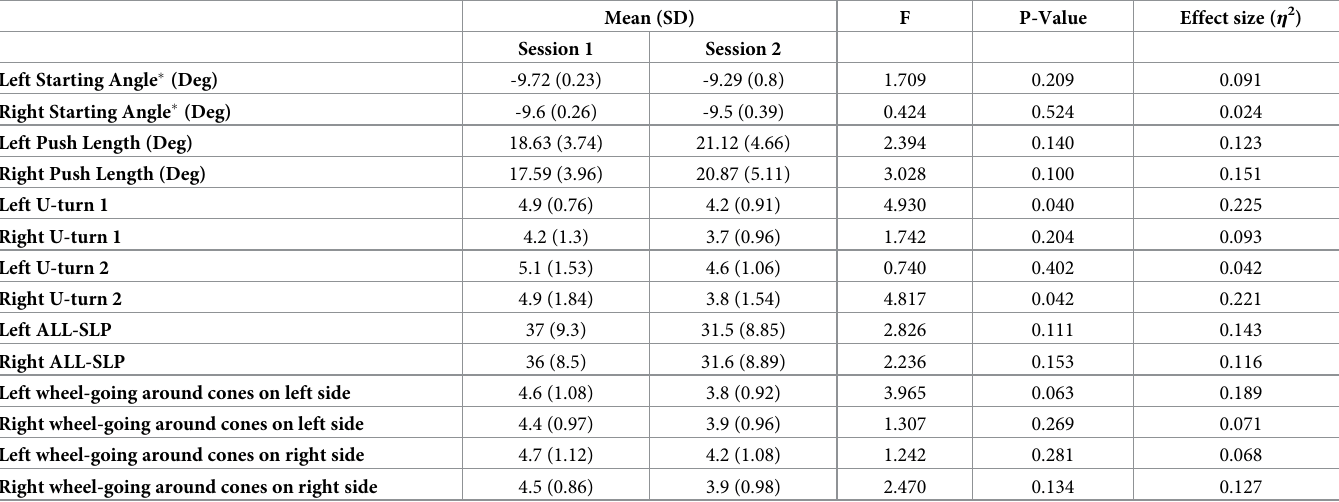
Table 5. Detailed statistical results for push parameters of the left and right wheel.